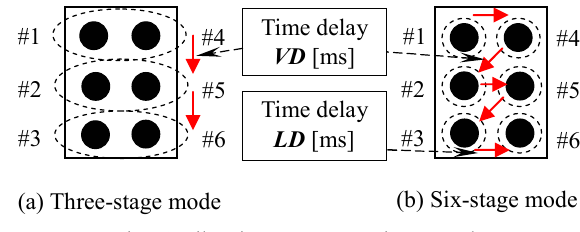
Fig.11 Vibration actuator Driven Mode